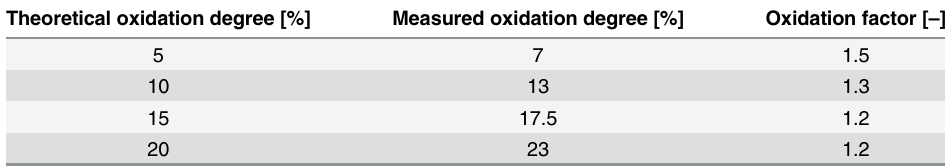
Table 3. Comparison of theoretically predicted and experimentally measured dextran oxidation